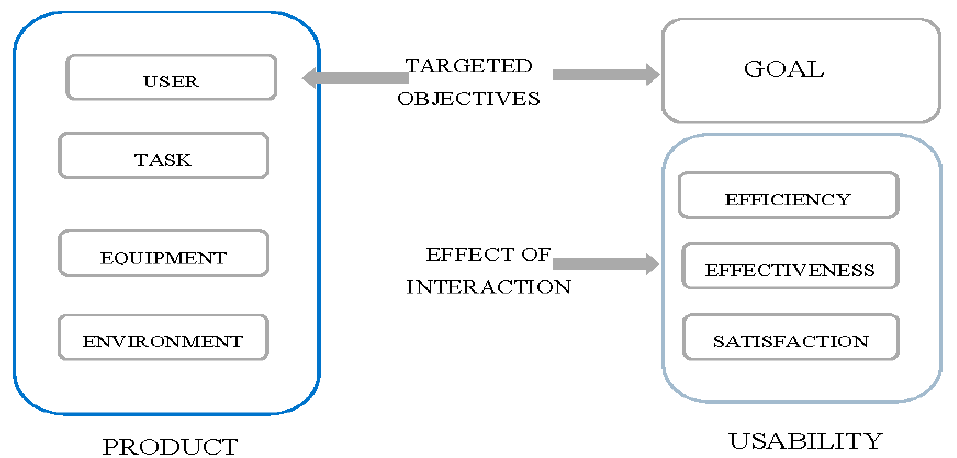
Figure 1. Achieving usability in an interactive product improvement cycle. Source: M. Kusiak, Usability of information system in the opinion of nurses (Master thesis) Medical University of Lodz, 2020.